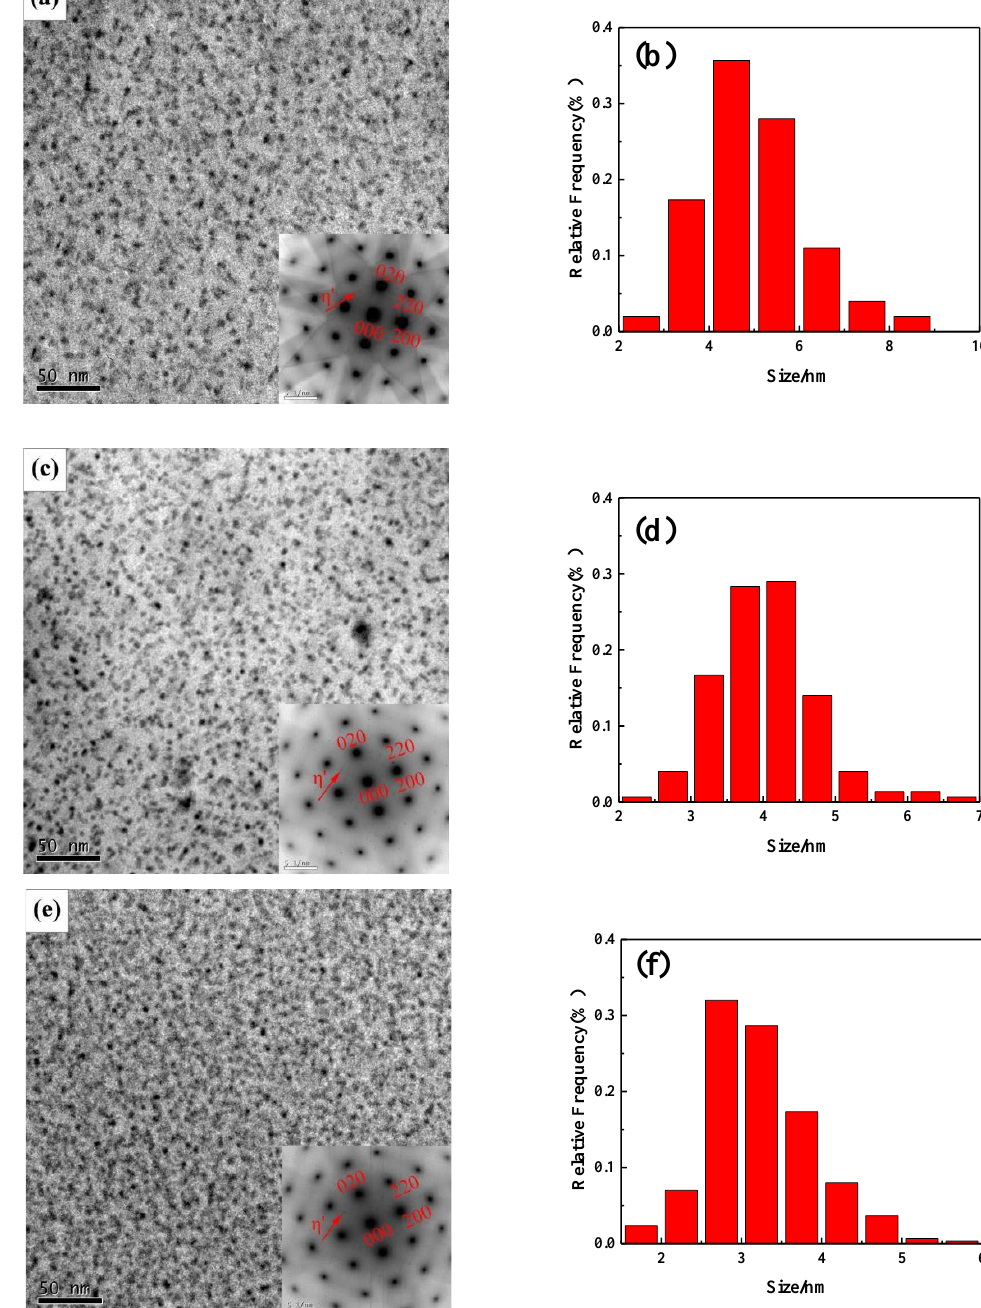
6.1, the size of η’ phased was 2.5 – 3.9 n m. Results indicated that the size of η’ phases significantly decreased with the decrease of the Zn/Mg ratio.